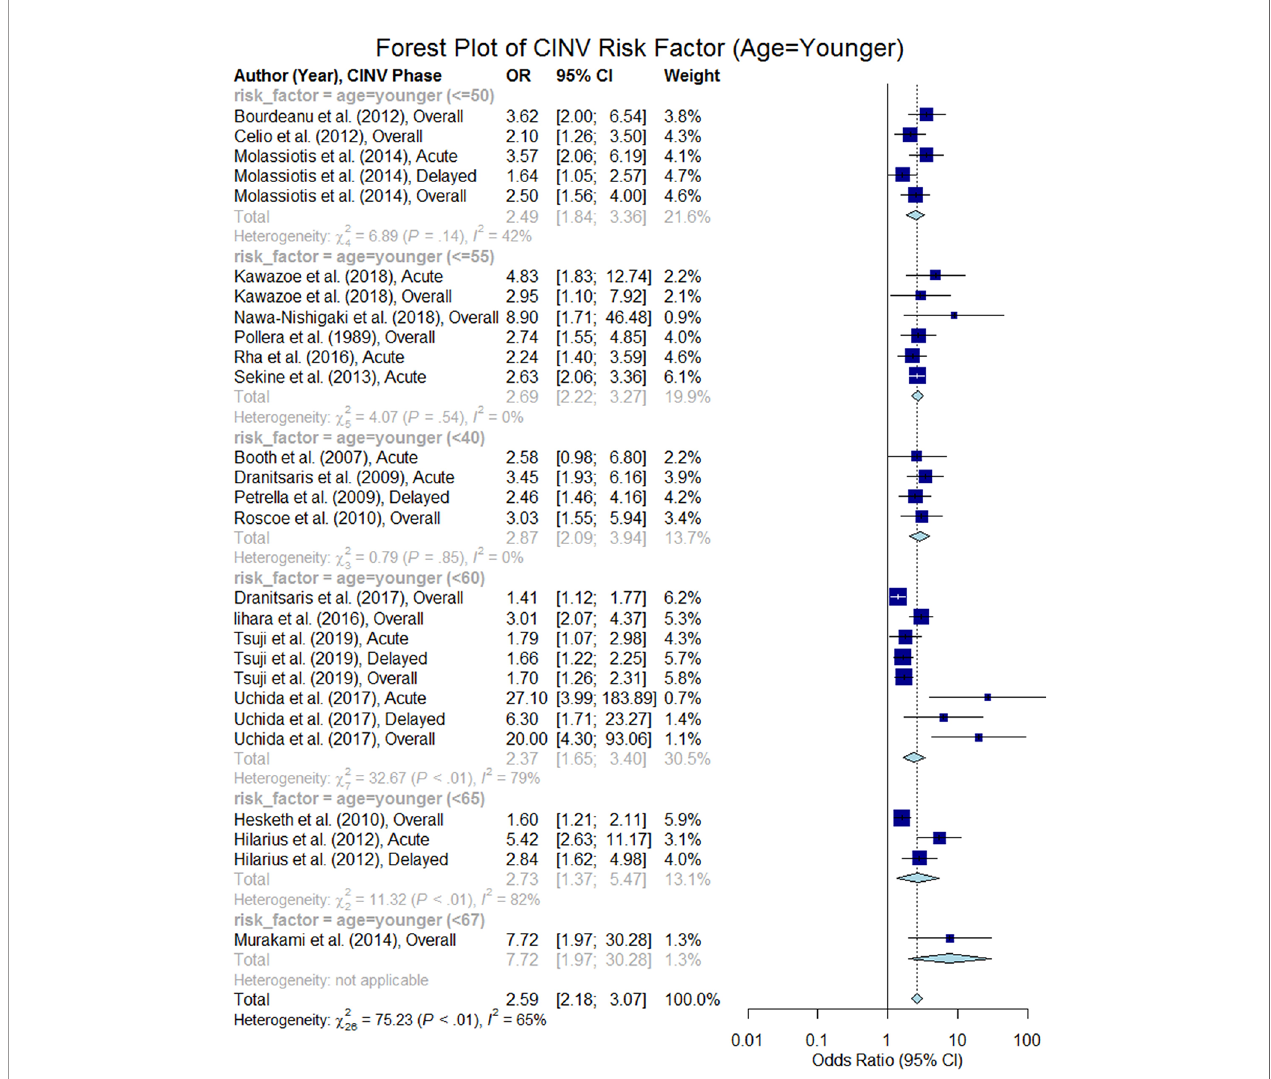
FIGURE 2 | Forest plot of Chemotherapy-Induced Nausea and Vomiting (CINV) risk factor (age = younger).